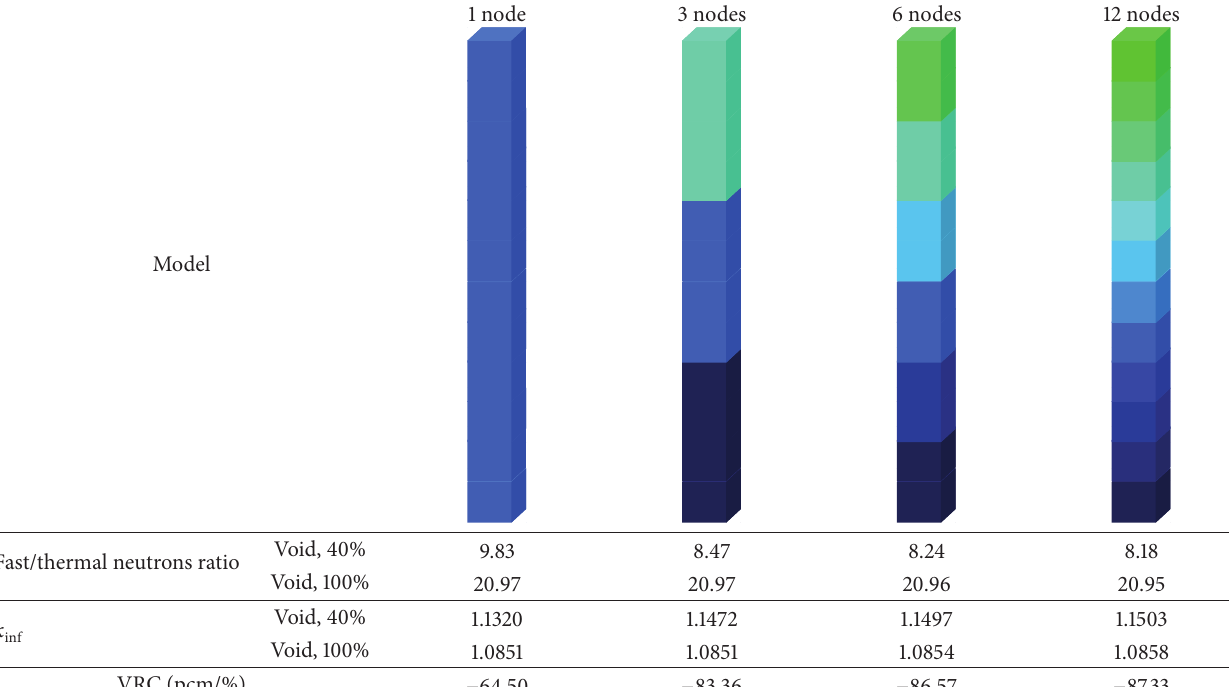
Table 3: The dependence of neutronic characteristics on nodalisation